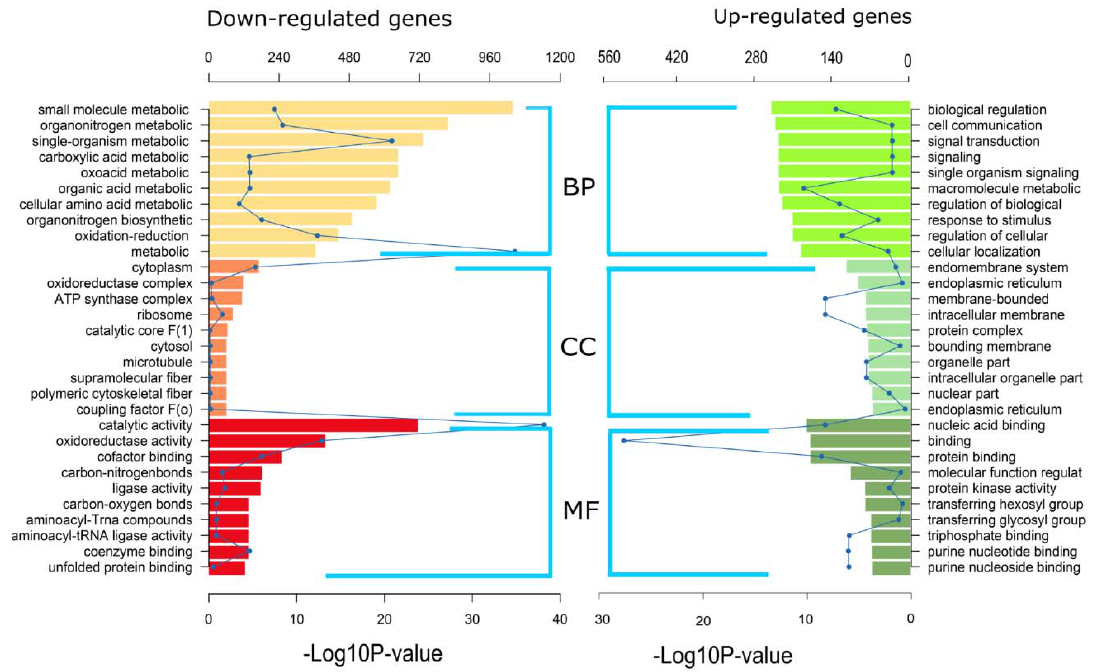
Figure 4. GO analyses of DEGs. The top 10 enriched GO terms of each category are shown on the graph. The curve means number of DEGs, and the column indicates Q ‐ value. BP: biological process, CC: Cellular component, MF: molecular function. Upon X axis indicates DEGs numbers representing as curve, the below X axis means − log10P ‐ value representing as column. The left or right Y axis indicates GO category.